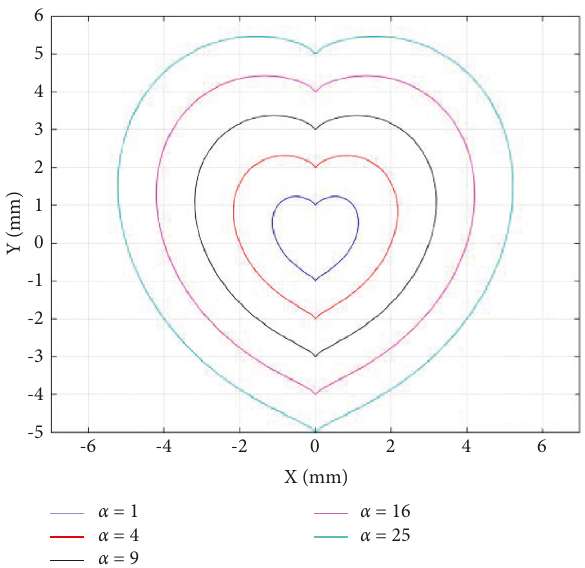
Figure 5: Varied sizes of heart-shaped